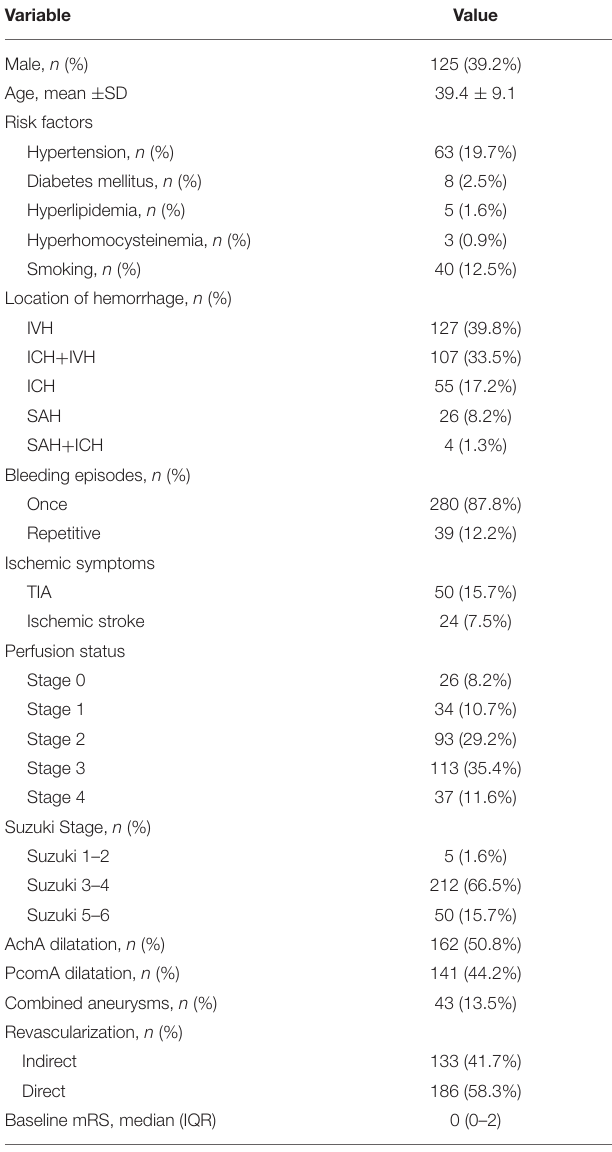
TABLE 1 | Baseline characteristics of 319 hemispheres with hemorrhagic